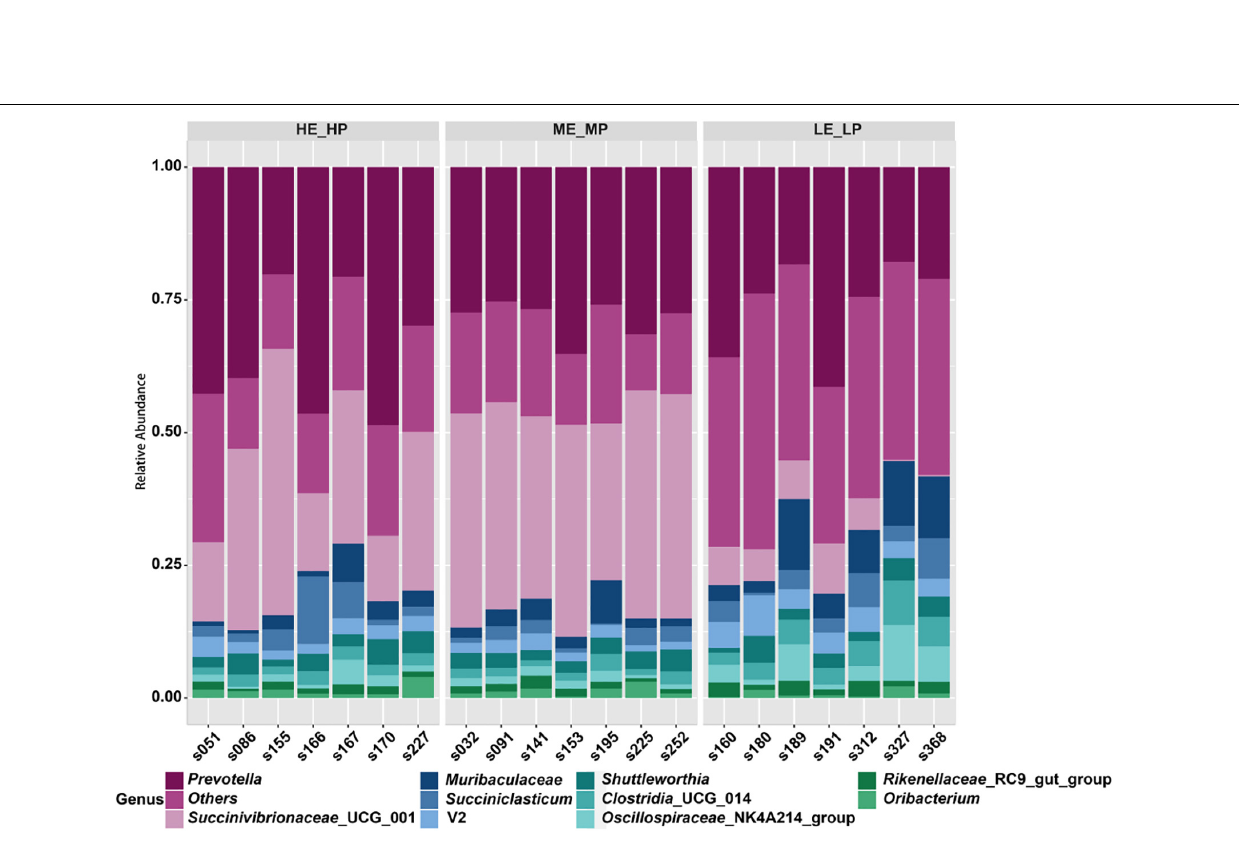
Frontiers in Microbiology |